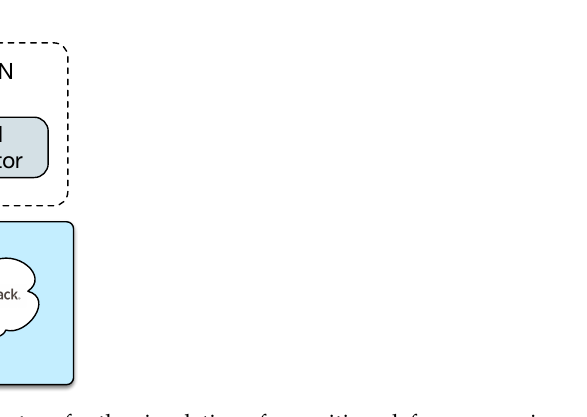
Figure 12. Federated MSaaS Infrastructure for the simulation of a maritime defense scenario. The architecture of the adopted OCEAN implementation is depicted in Figure 13.